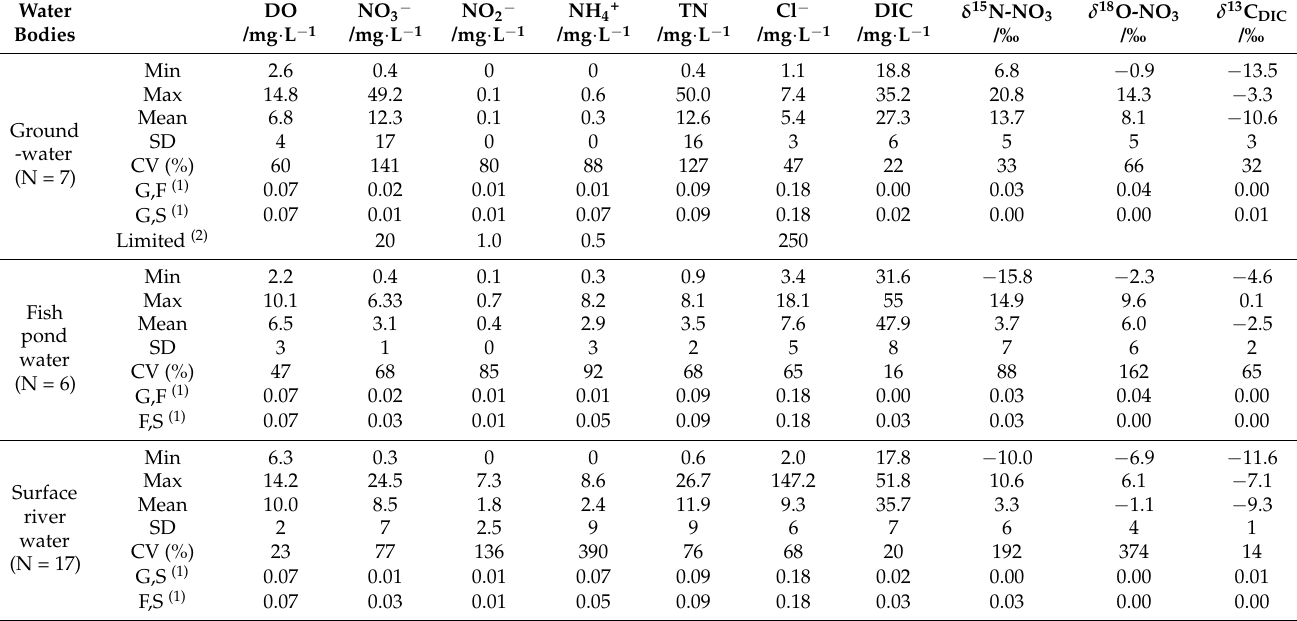
Table 1. Water chemistry and isotopic characteristic values of Huixian